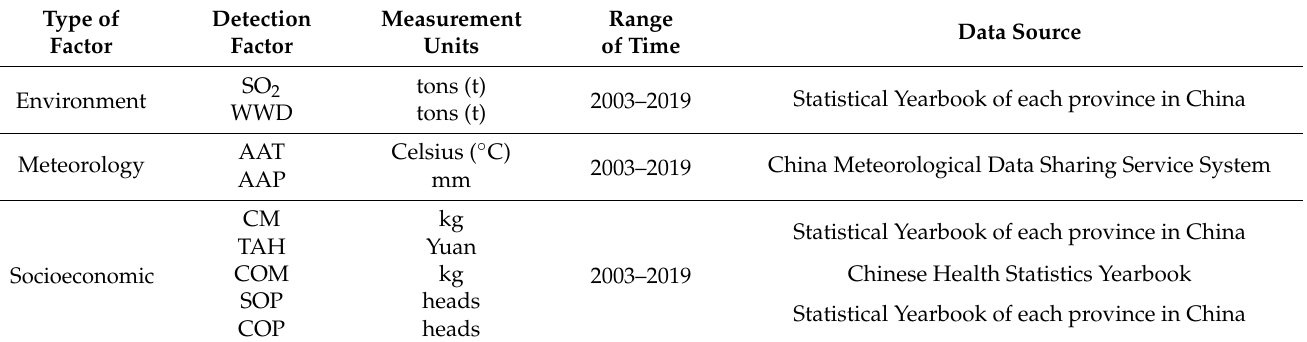
Table 1. Description of